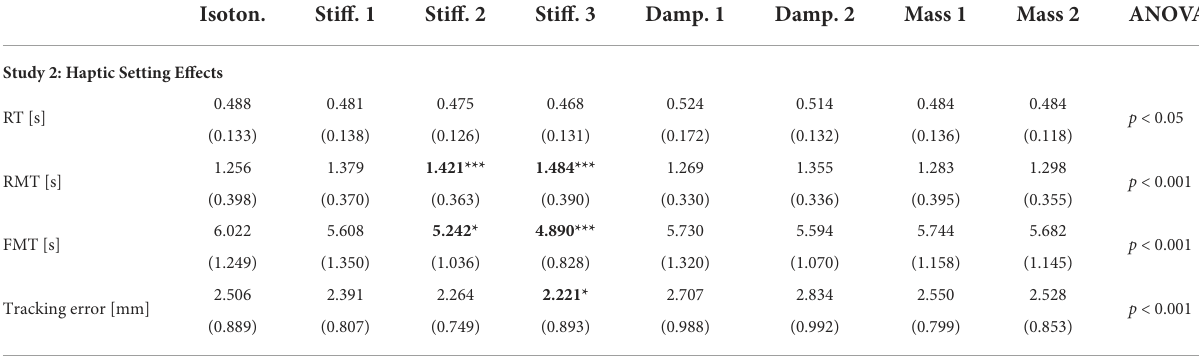
TABLE 5 Effects of haptic settings on performance measures: Means, SD (in parentheses), and rmANOVA main effects. Isoton.